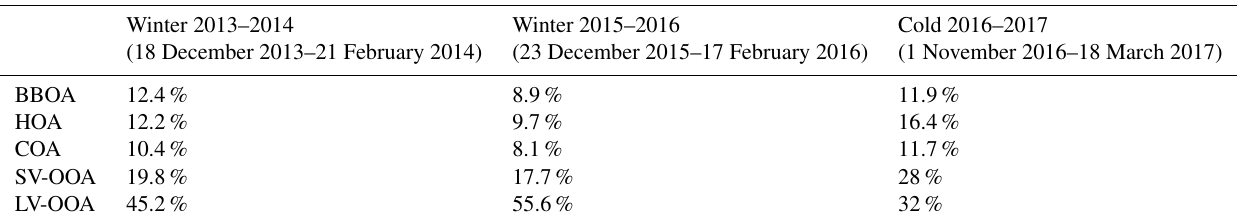
Table 2. Contribution of the five organic aerosol components to the total organic fraction during the three individual winter